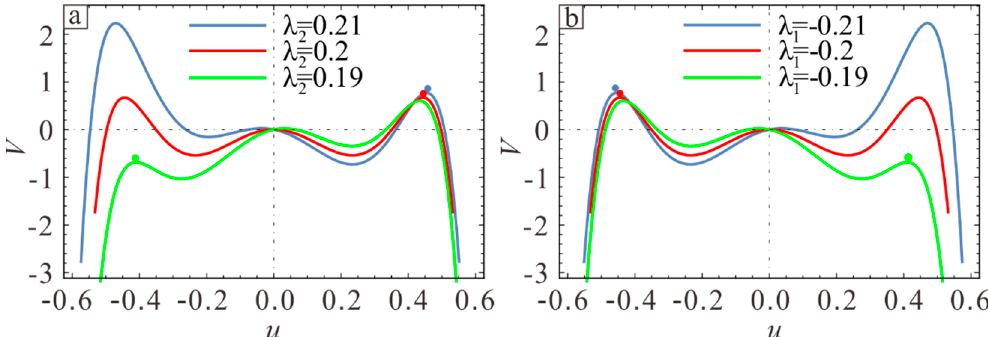
λ on static Figure 7. The influence of section parameters on potential energy. ( a ) The influence of λ 2 on static 2